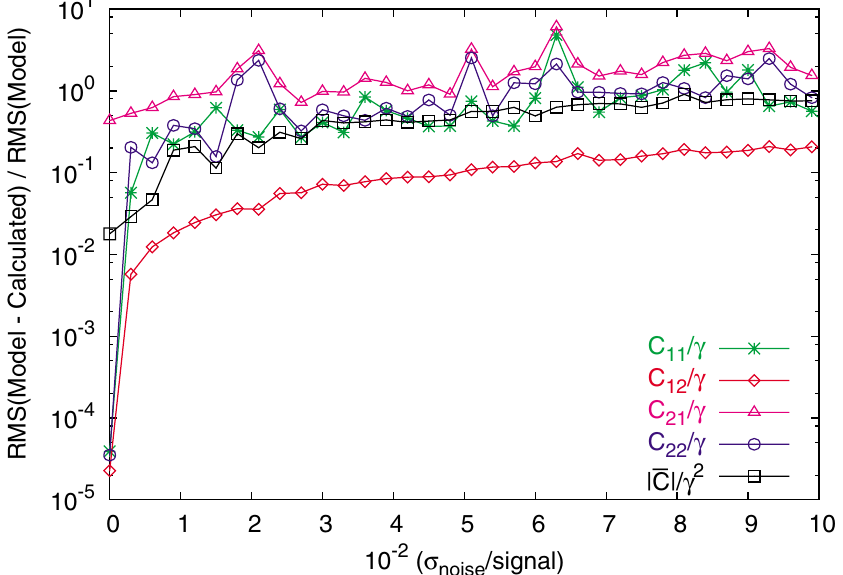
FIG. 5. (Color) Normalized rms of the difference of j C j =(cid:20) 2 between MAD-X model and SVD computed values for increasing amount of Gaussian noise in turn-by-turn data. Horizontal and vertical tunes are Q